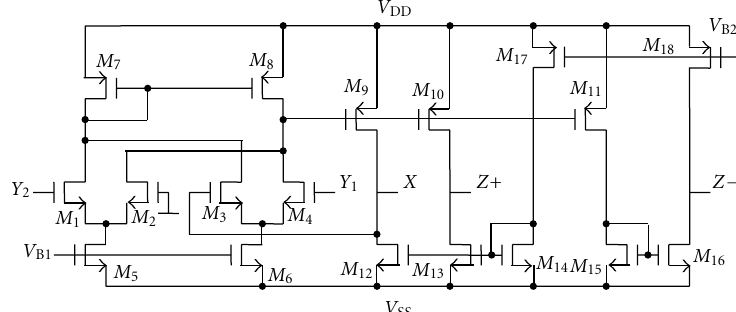
Figure 9: CMOS circuit of the DVCC [13].